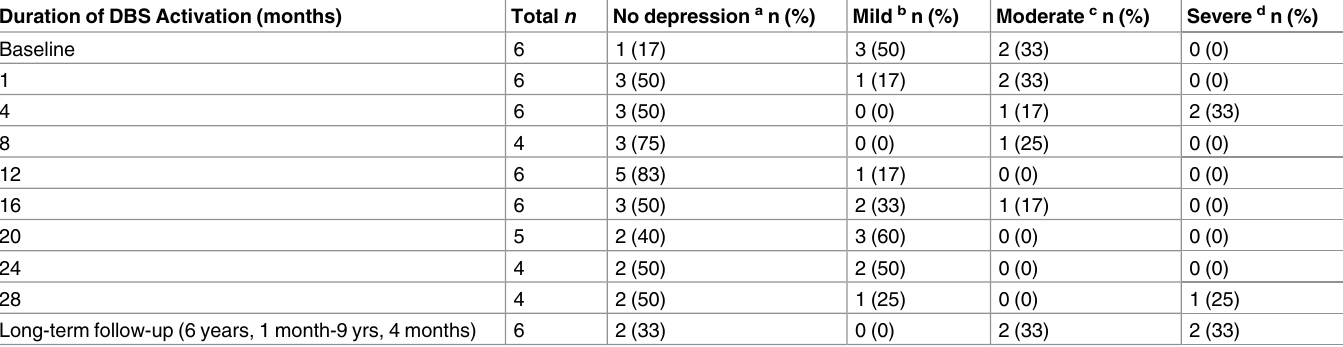
Table 2. HAM-D depression levels across follow-up, per cutoff guidelines.